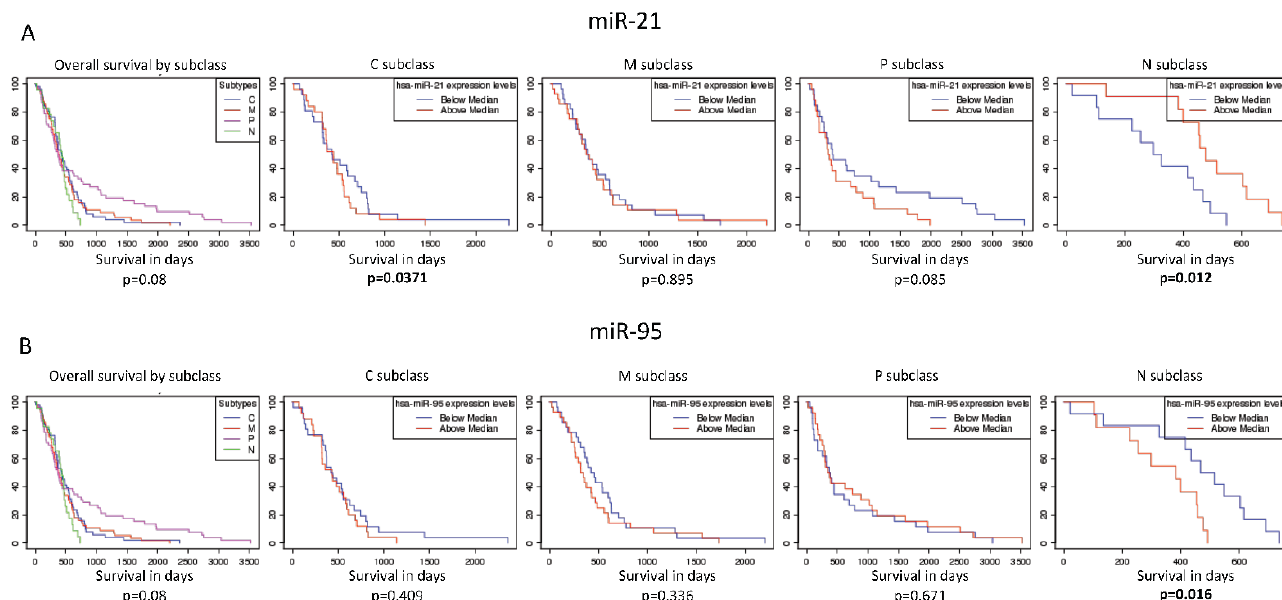
Figure 4. Kaplan–Meier analysis of miR-21 ( A ) and miR-95 ( B ) in the four subtypes of GBM of the TCGA patients.